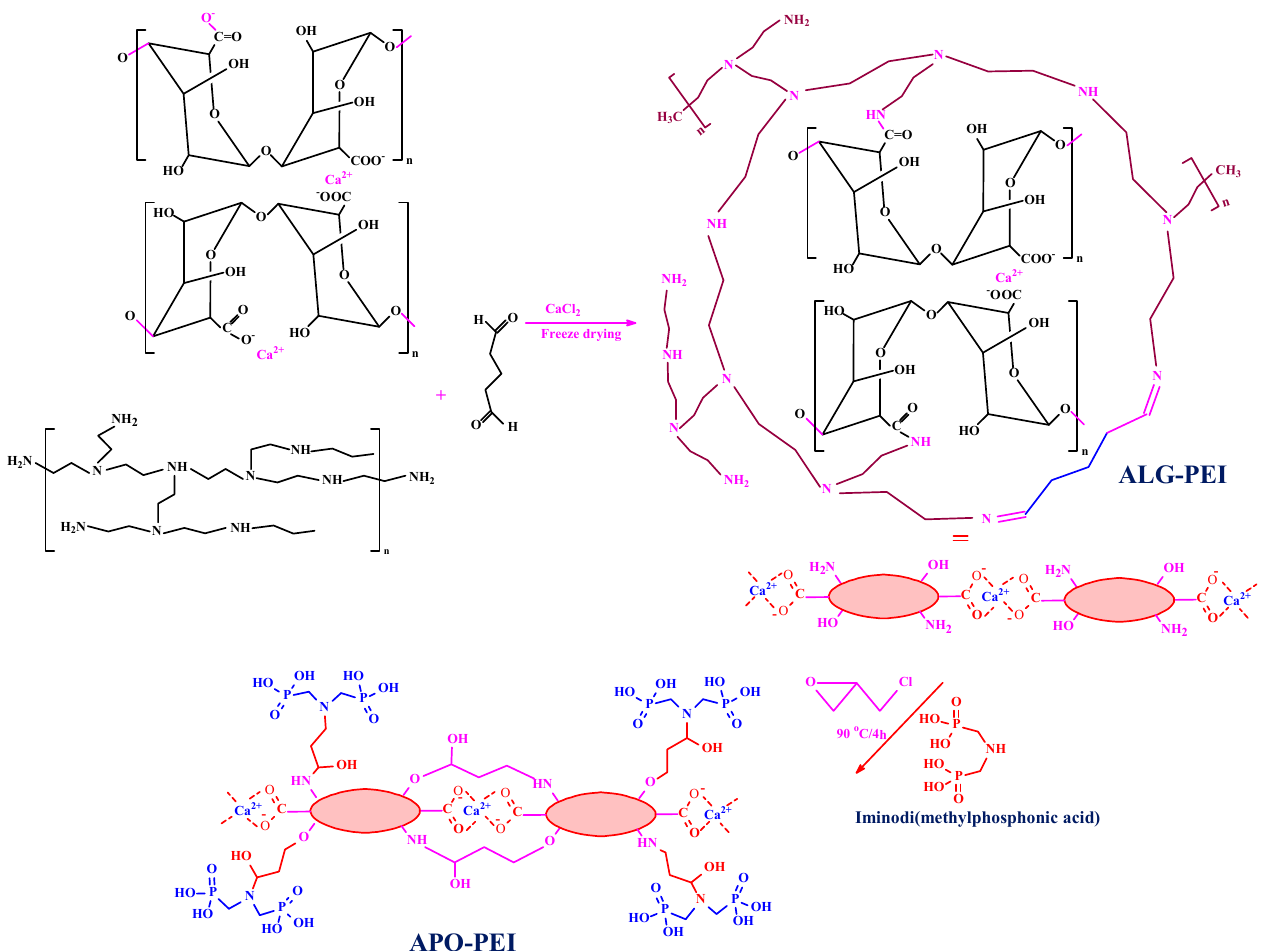
Scheme 2. Synthesis procedures for the preparation of ALG-PEI and APO-PEI